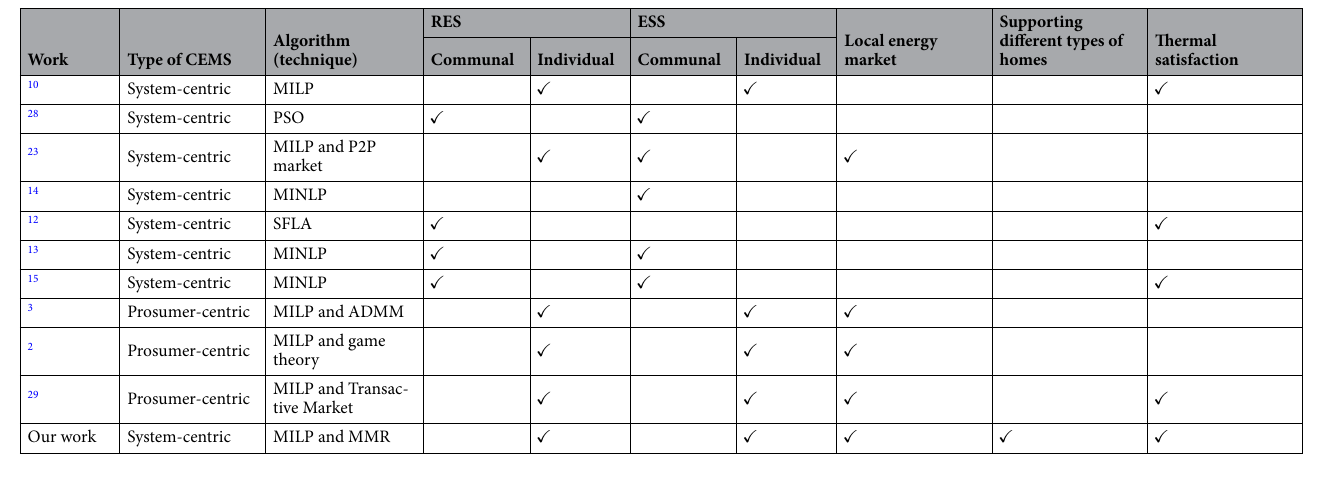
Table 1. A comparison between this paper and the papers mentioned in the related